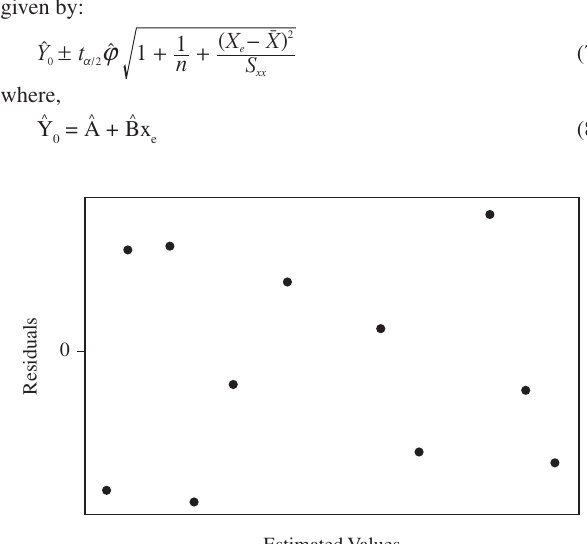
) against the estimated values i